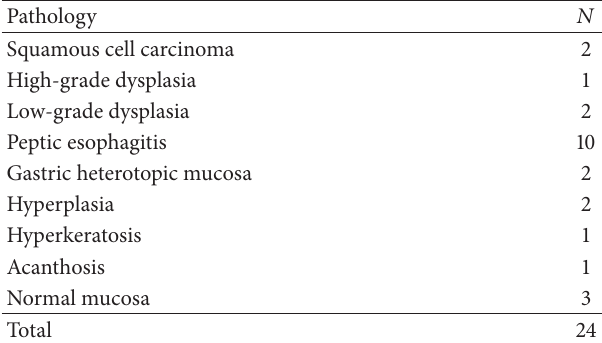
Table 1: Histopathological diagnosis of mucosal